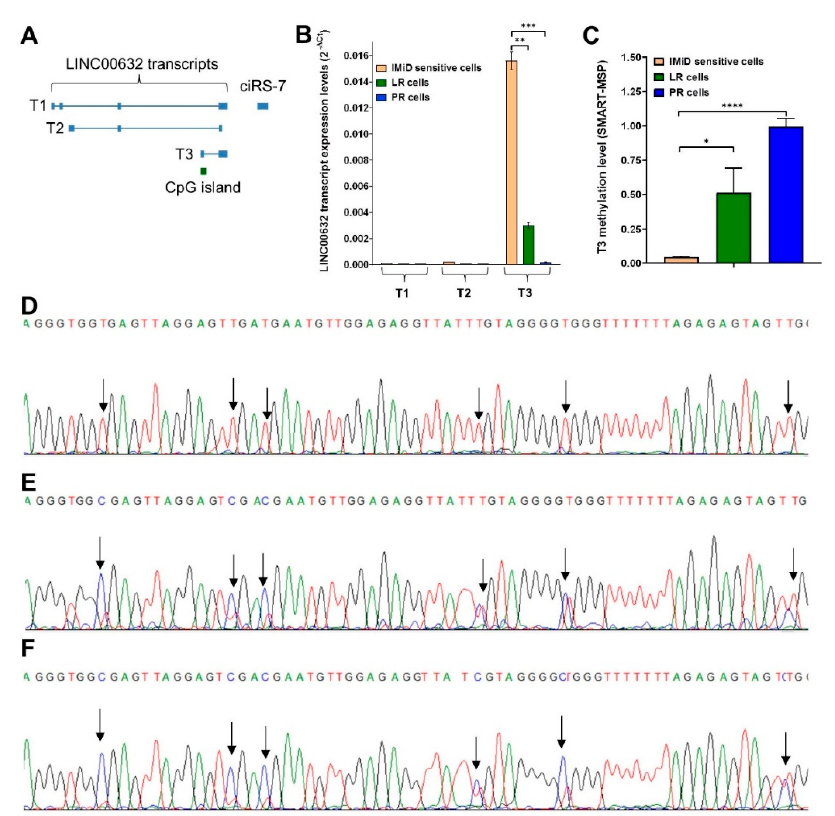
Figure 5. Downregulation of ciRS-7 is associated with increased methylation of the promoter driving its expression. ( A ) Schematic representation the three transcript variants, denoted as T1, T2 and T3, of LINC00632. The CpG island associated with T3 is indicated (not drawn to scale). ( B ) Expression levels (analyzed by RT-qPCR) of the LINC00632 transcript variants in parental (IMiD-sensitive), LR and PR cells. Error bars reflect technical triplicates. ( C ) Relative methylation levels (analyzed by SMART- MSP) of T3 in IMiD-sensitive, LR and PR cells, normalized to a fully methylated control. Error bars reflect technical triplicates. ( D – F ) Sanger sequencing chromatograms of T3 in parental (sensitive) cells ( D ), LR cells ( E ) and PR cells ( F ), with arrows indicating the CpG sites. LR, lenalidomide-resistant, PR, pomalidomide-resistant. * p < 0.05, ** p < 0.01, *** p < 0.001, **** p < 0.0001 (unpaired t